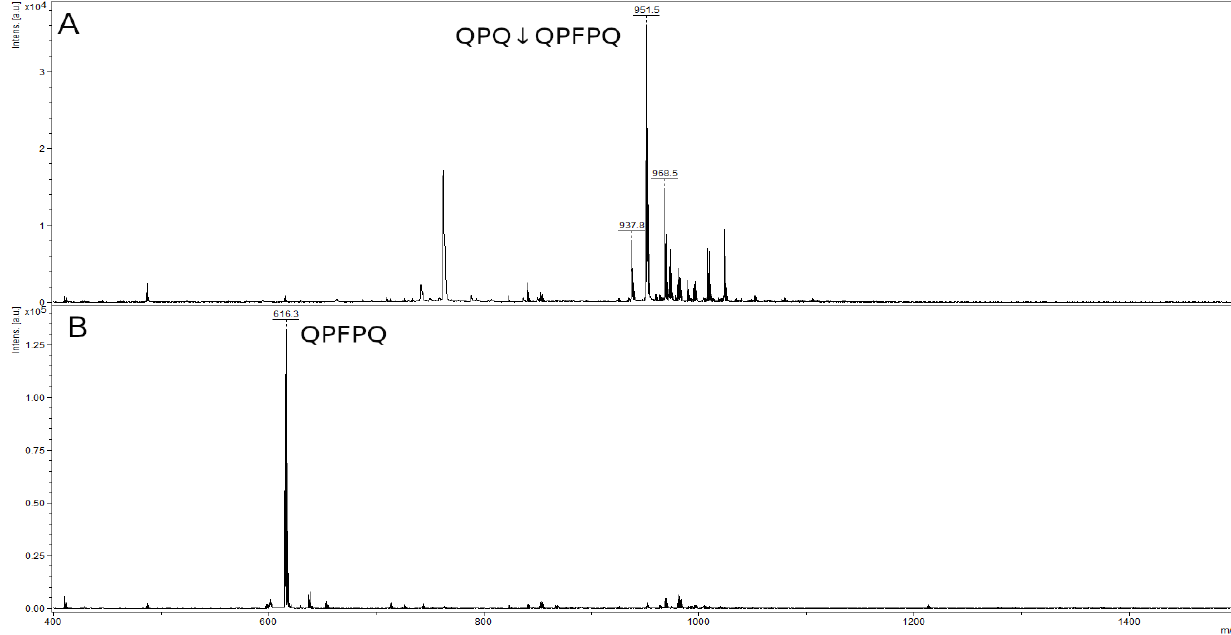
Figure 9. Mass spectra of the original 8-mer peptide QPQQPFPQ ( A ) and hydrolysate by rTcCathL1 after 40 min of incubation ( B ).